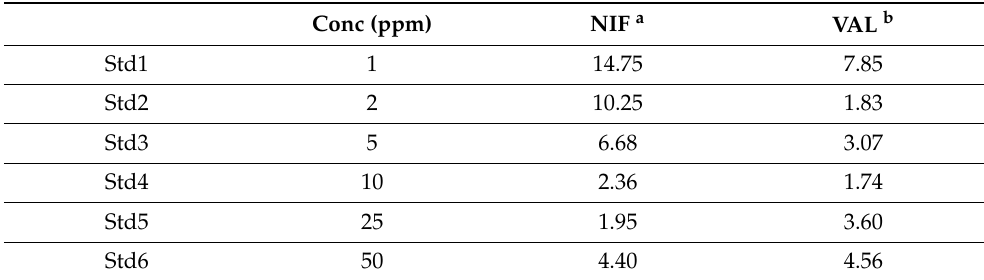
Table 5. The percent deviation of nine replications of each standard.